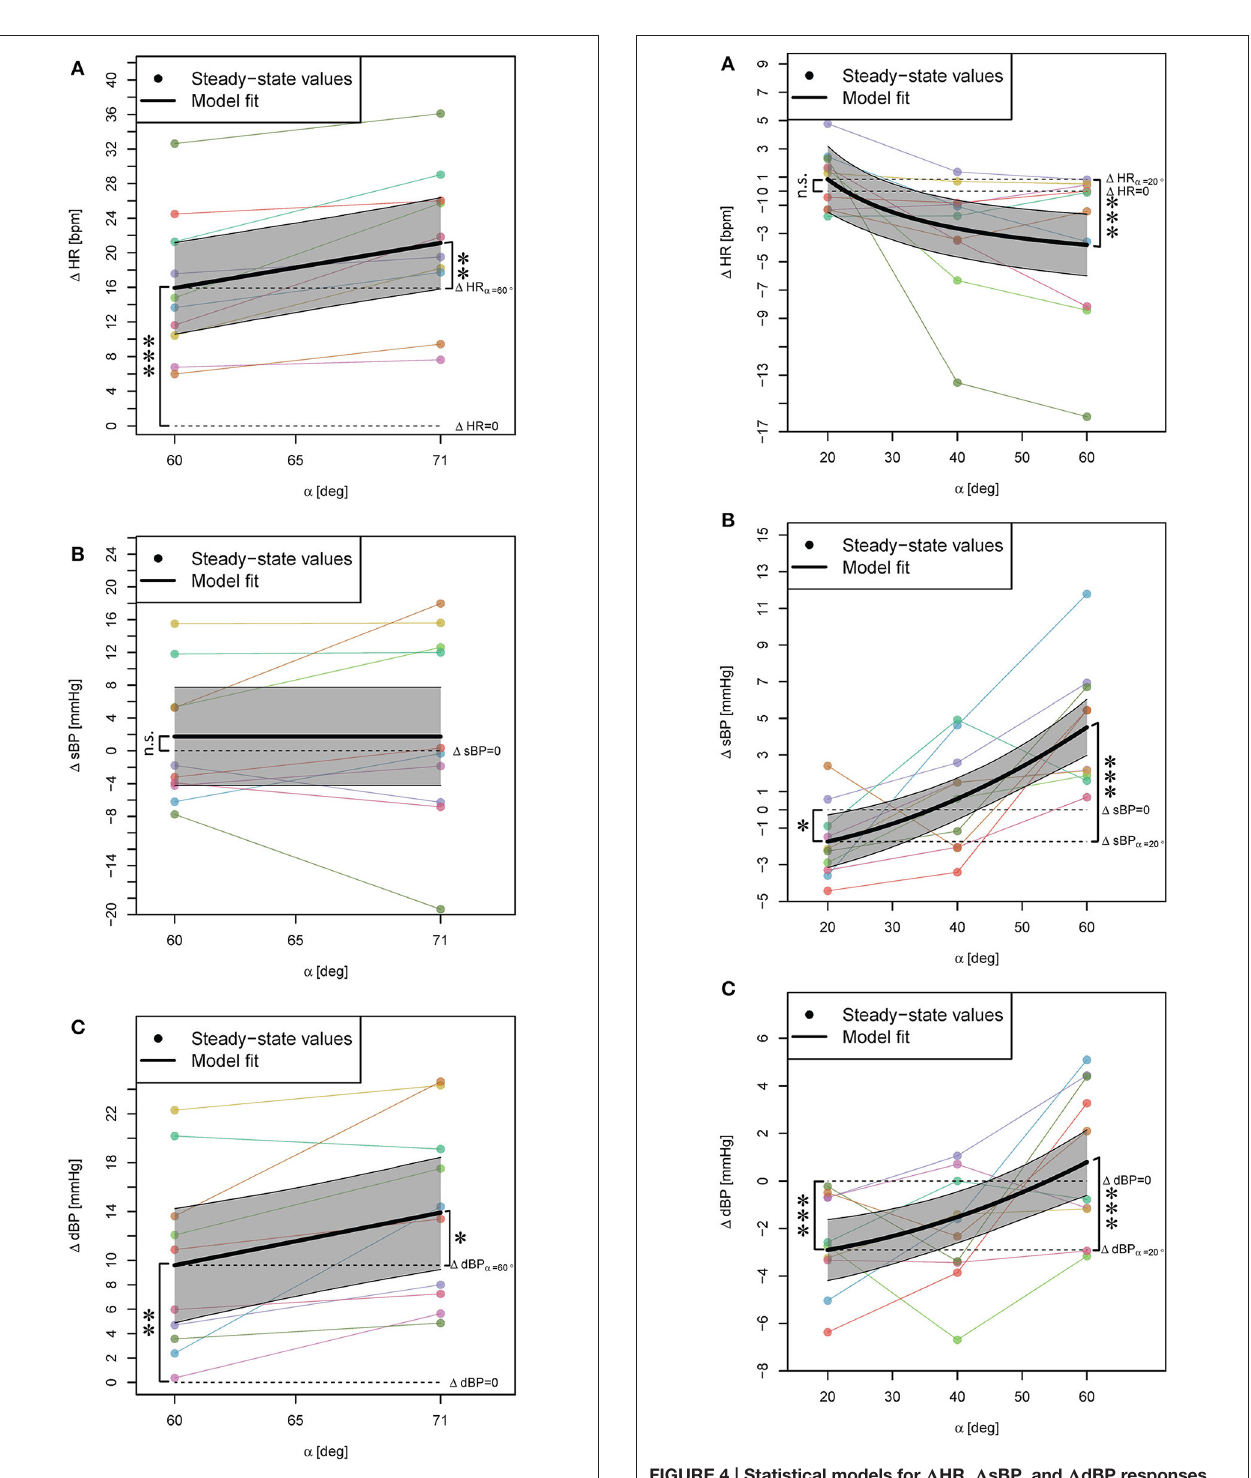
FIGURE 4 | Statistical models for 1 HR, 1 sBP, and 1 dBP responses to PE (independent of FES) during head-up tilt (A–C). Steady-state values correspond to the average response of two conditions, i.e., PE without and with FES application, and for each subject they are connected with lines. The highlighted areas show 95% CI. The signs * and *** mark significant findings with p 0.05 and 0.001, respectively. n . s . marks non-significant ≤